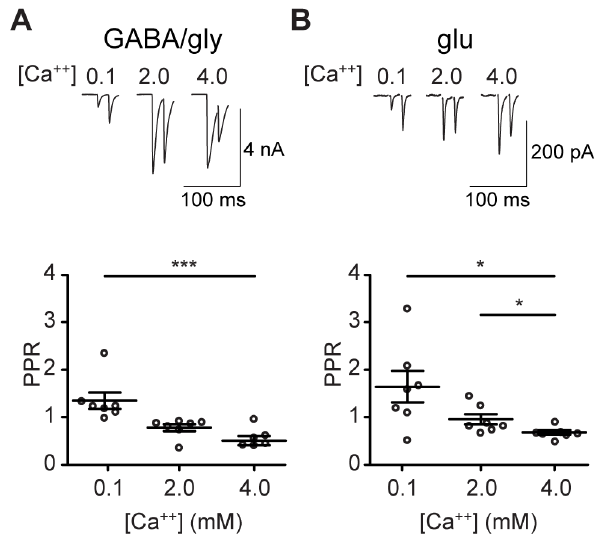
Figure 1. Short-term plasticity is Ca ++ -dependent for both GABA/gly and glutamate. A ) PPRs for GABA/gly neurotransmission shift from facilitating at low external Ca ++ (0.1 mM) to depressing at high external Ca ++ (4.0 mM) (P=0.0003, F=12.2, Friedman test, Dunn’s post hoc P , 0.005). B ) PPRs for glutamate also shift from facilitating to depressing in a Ca ++ -dependent manner (P=0.02, F=7.7, Friedman test, Dunn’s post hoc P , 0.05). Recordings from P3–5 slices.